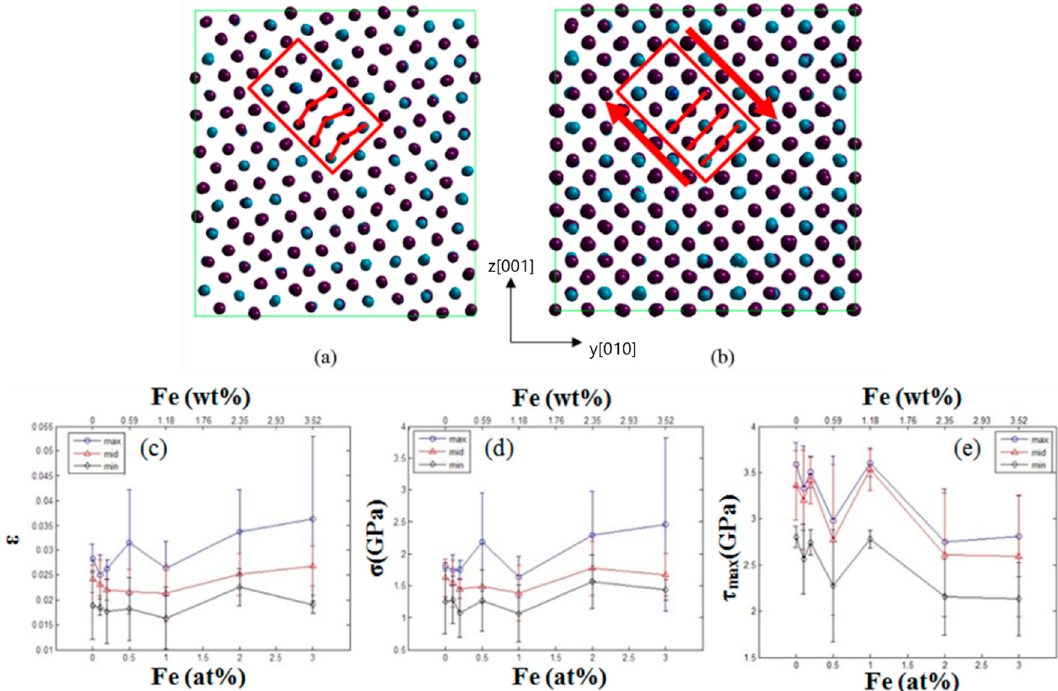
Figure 3. Molecular dynamics simulation results. The darker and light-colored symbols represent the Ni and Al atoms, respectively. ( a ) Lattice-misfit distortion before yielding; ( b ) distorted atoms shuffle to high-energy sites. The calculated parameters of minimum ( ◊ ), medium ( Δ ), and maximum ( ○ ) values at the yielding as a function of Fe-addition for ( c ) lattice strain; ( d ) local stress; and ( e ) τ max , respectively.